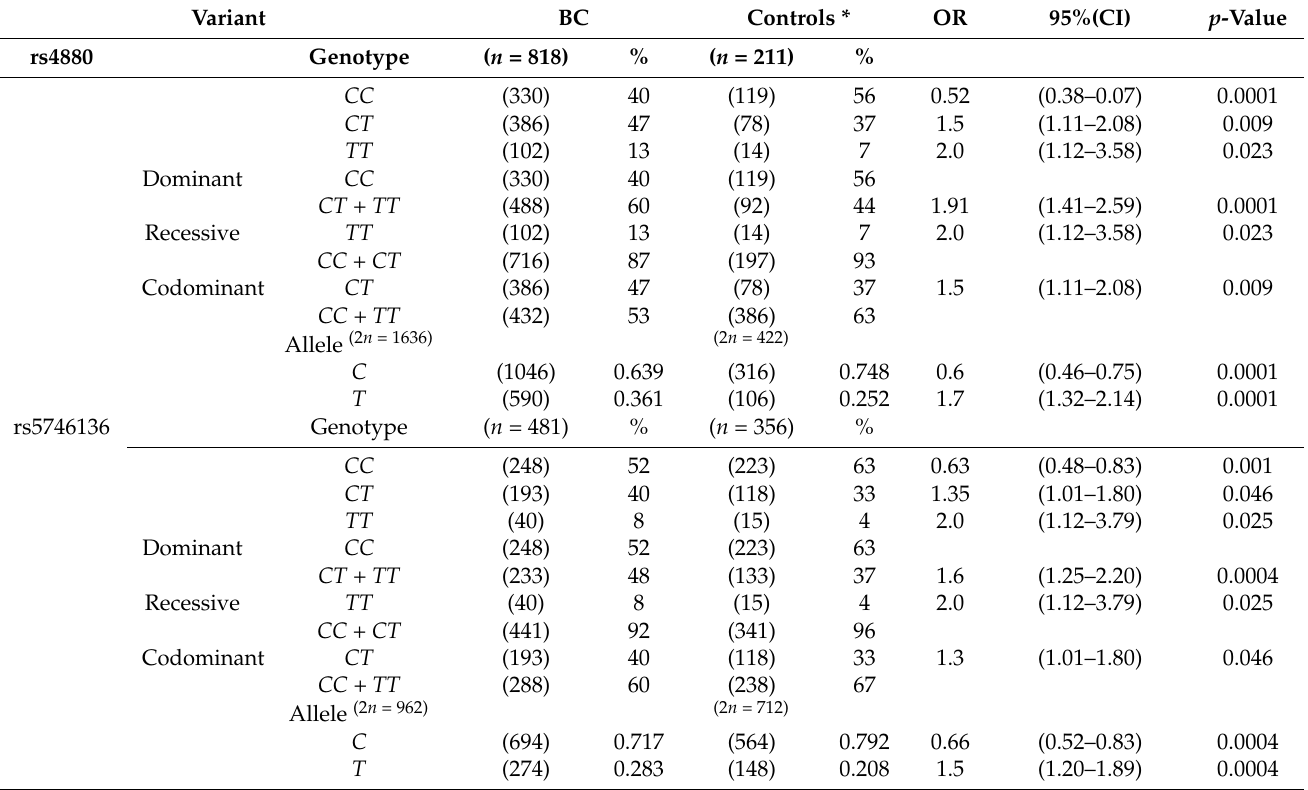
Table 3. Genotype and allelic distribution of the rs4880, and rs5746136 variants of SOD2 in BC patients and